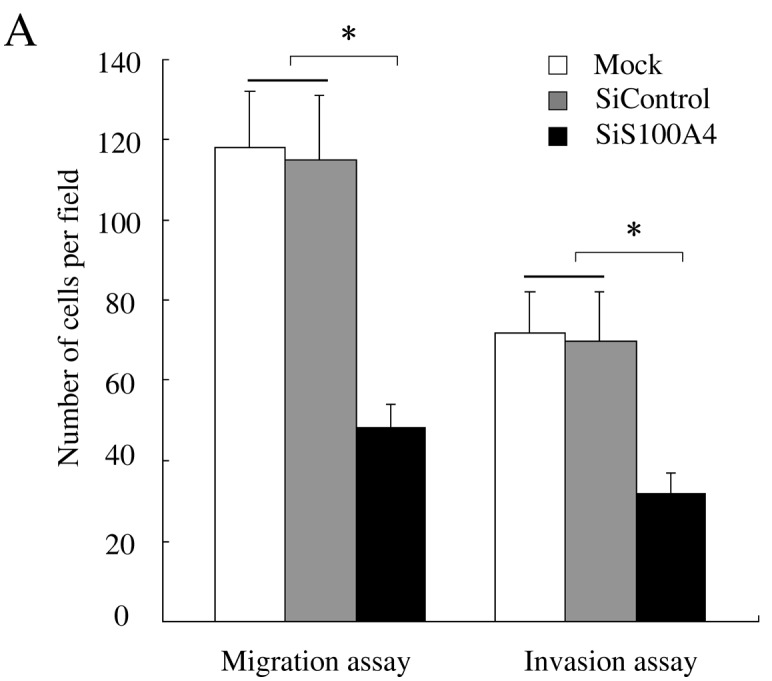
Downregulation of S100A4 by RNAi attenuated migration and invasion activity of SW620 cells. (A) Statistical plots of the number of cells that invaded the Transwell membranes of the haptotactic migration assay and Matrigel invasion assay. Data represent the mean ± standard deviation (SD) of three independent experiments. *Specific comparison between siS100A4 group and mock control, siControl group (P<0.05). (B) The polycarbonate filters were stained with toluidine blue and viewed with a light microscope (magnification, ×100).